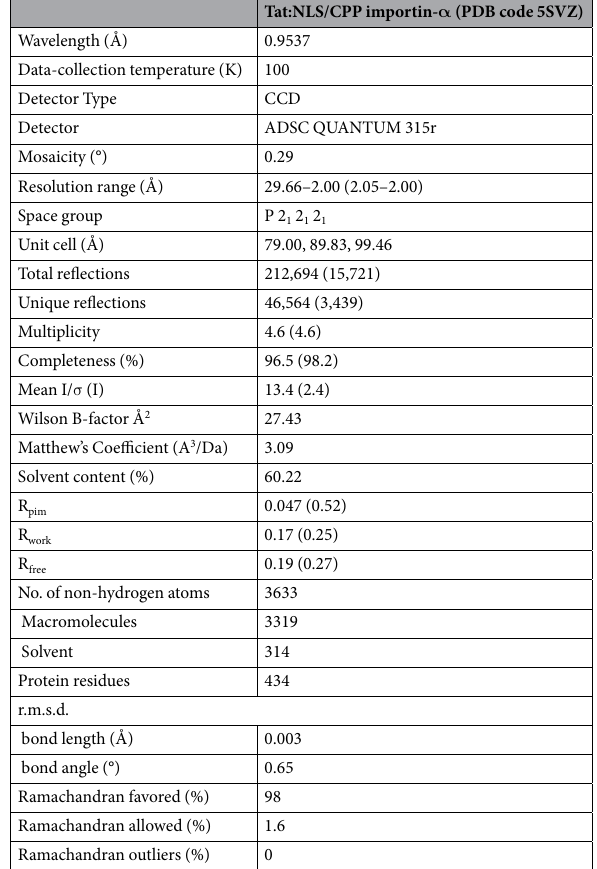
Table 1. Data collection and refinement statistics for structure of importin- α in complex with HIV-1 Tat:NLS/ CPP domain. Values in brackets describe the highest resolution